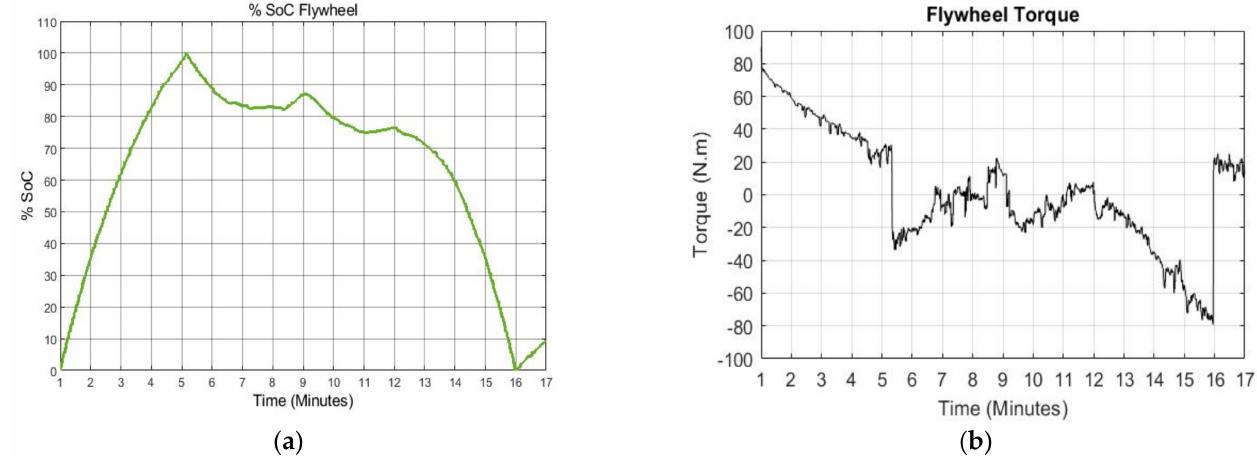
Figure 29. ( a ) %SoC of flywheel; ( b ) Flywheel